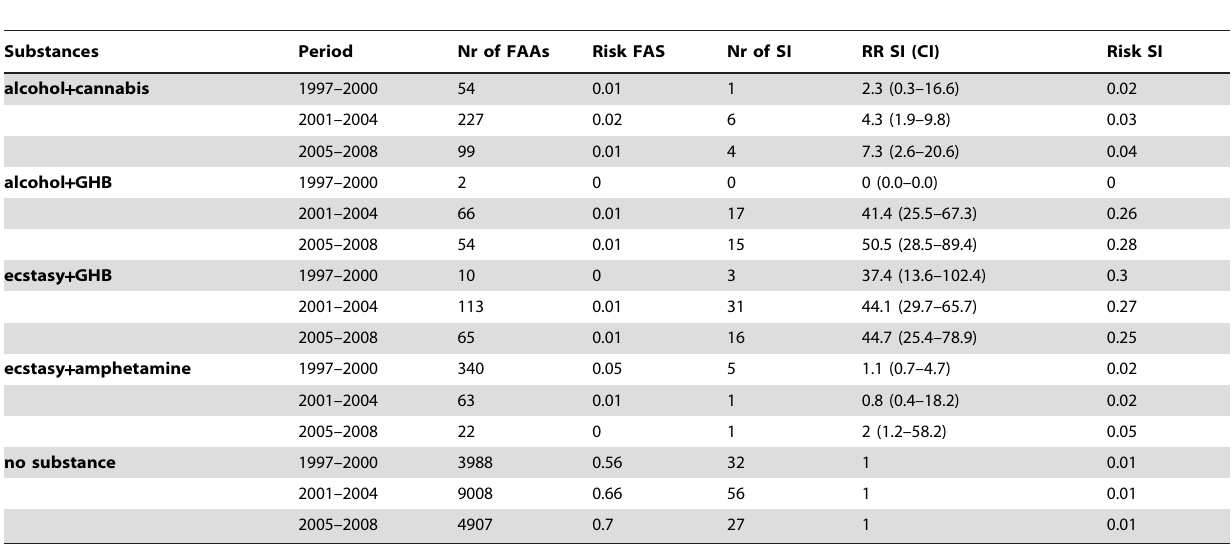
Table 6. Number and risk of first aid visits and serious incidents associated with using different combinations of